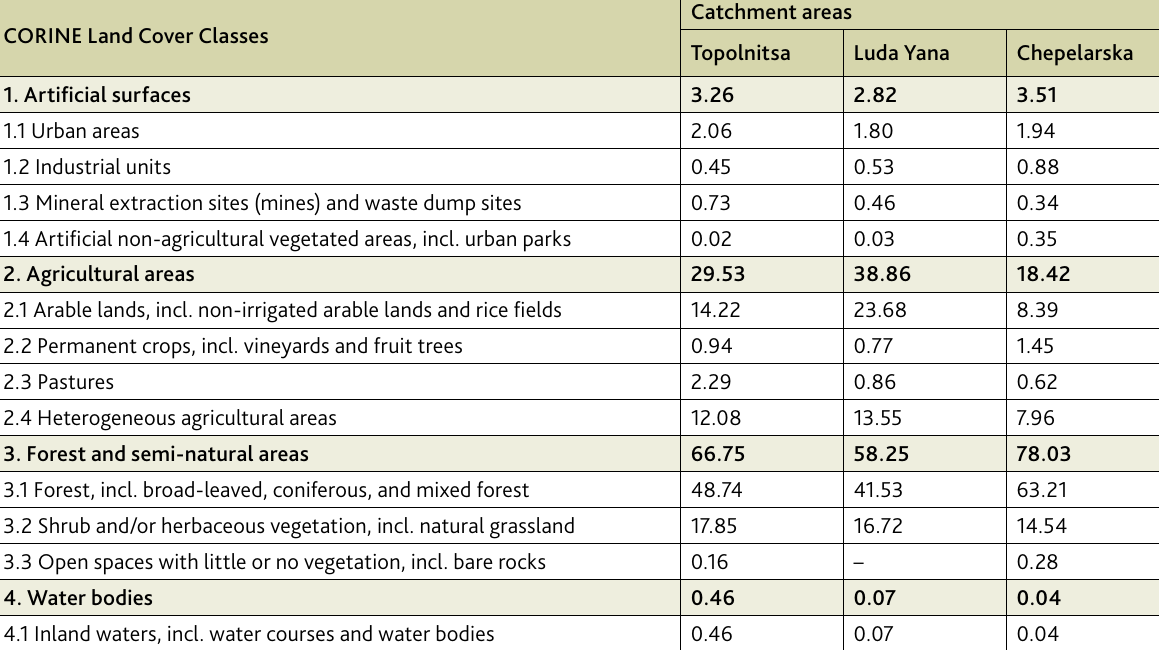
Table 9. Distribution of CORINE Land Cover Classes 2018 (% of catchment areas) CORINE Land Cover